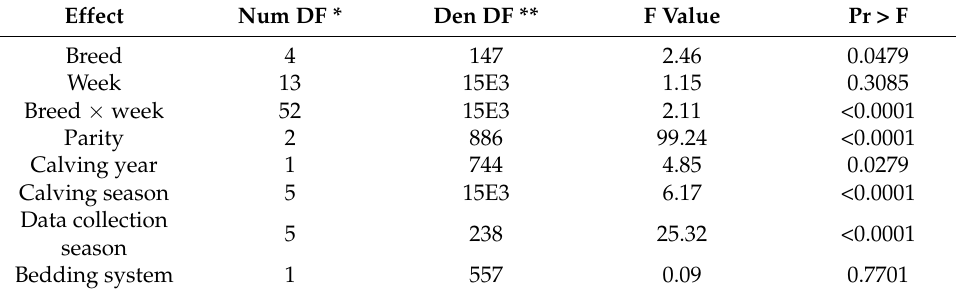
Table A11. Variance analysis results for the variable fat (kg/day).